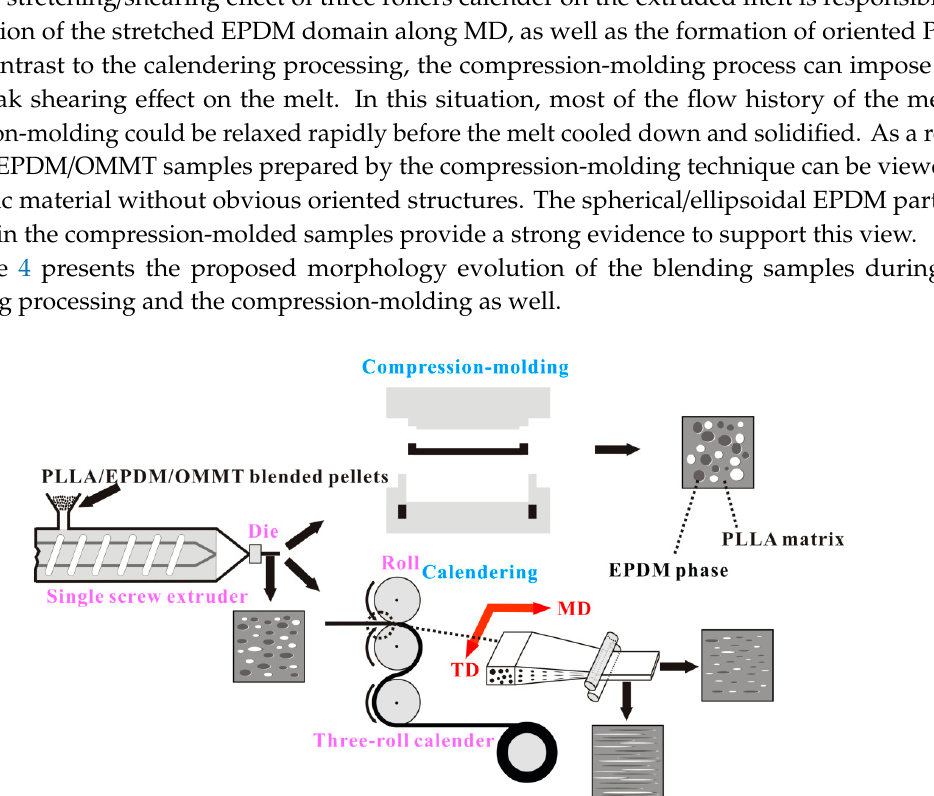
Figure 6. XRD patterns of PLLA and PLLA/EPDM/OMMT (90/10/ x ) samples prepared by compression-molding and calendering. According to the results obtained from the tensile test, SEM observation, XRD, and DSC measurements, the respective tensile fracture mechanisms for the calendered samples and the compression-molded samples were proposed as follows: ε of the compression-molded PLLA sample